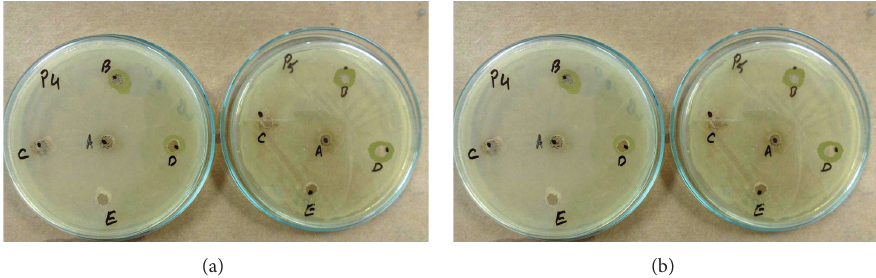
Figure 12: (a) Zone inhibition of FeNPs against P 4 = Escherichia coli , P 5 = Salmonella enterica , B = Lawsonia inermis , and D = Gardenia jasminoides . (b) Zone inhibition of FeNPs against P 4 = Staphylococcus aureus , P 5 = Proteus mirabilis , B = Lawsonia inermis , and D = Gardenia jasminoides